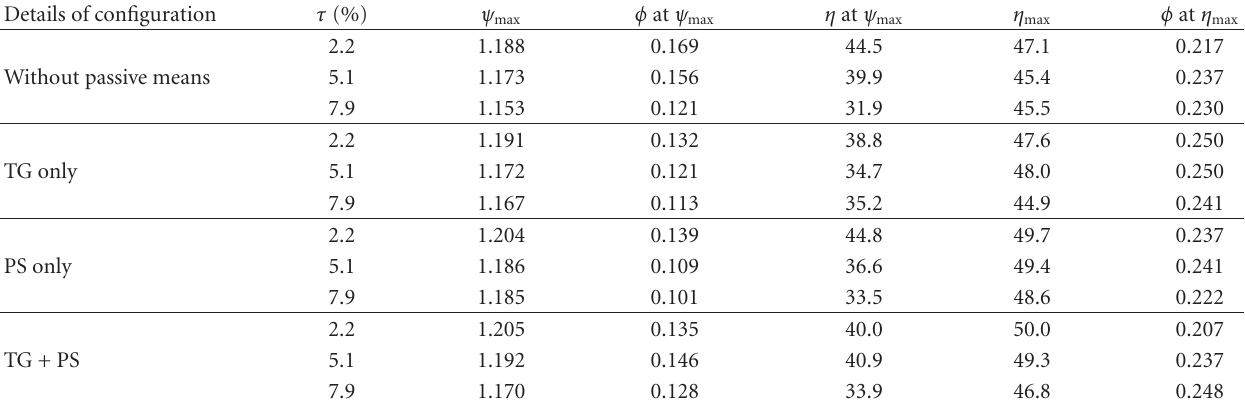
Table 4: E ff ect of tip clearance on ψ max and η max